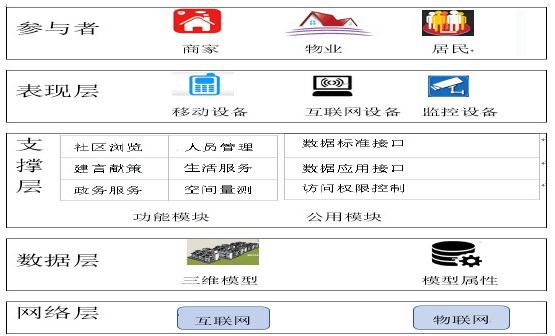
Fig.4 The logical structure of the system